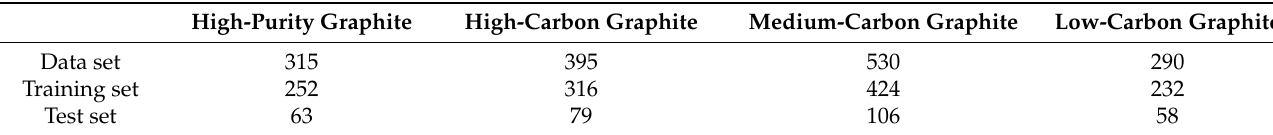
Table 1. Graphite data set.